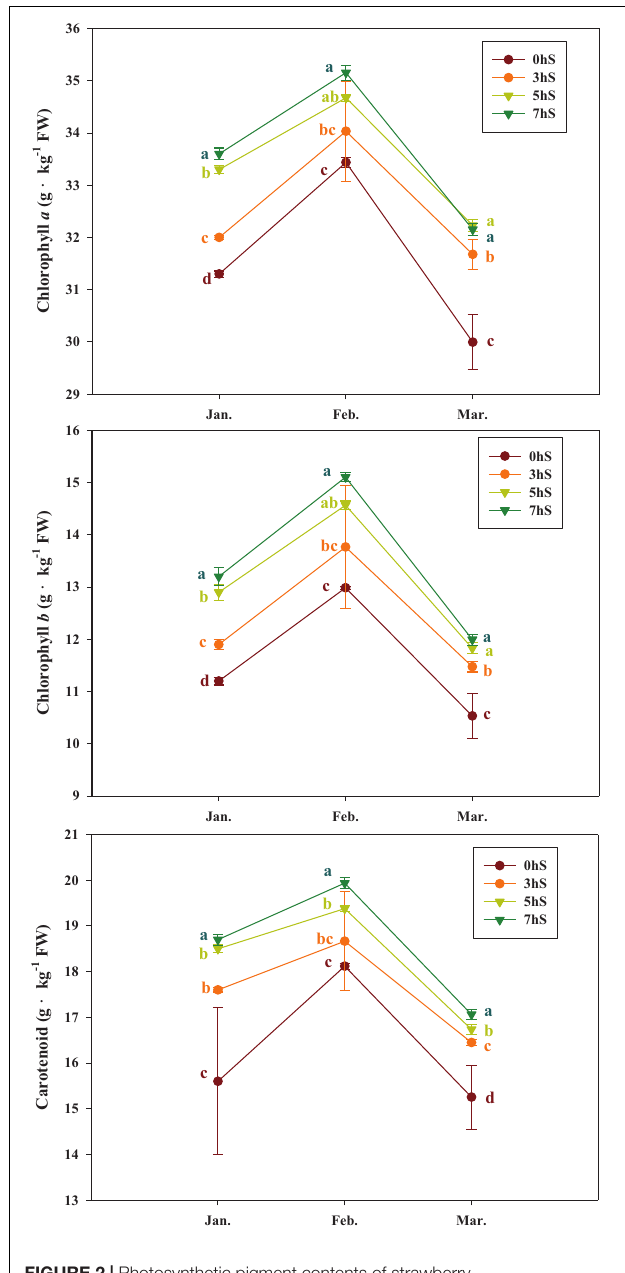
FIGURE 2 | Photosynthetic pigment contents of strawberry ( Fragaria × ananassa ) leaves (30 ± 5 days old) grown under various light intensity conditions in a smart greenhouse. Vertical bars represent standard deviations. Different letters above the bars indicate significant differences among treatments (Duncan’s multiple range test, p < 0.05, n = 3). 0 hS, non-shading treatment (control); 3 hS, three hours of shading until 10:00; 5 hS, five hours of shading until 12:00; 7 hS, seven hours of shading until 14:00. FW, fresh